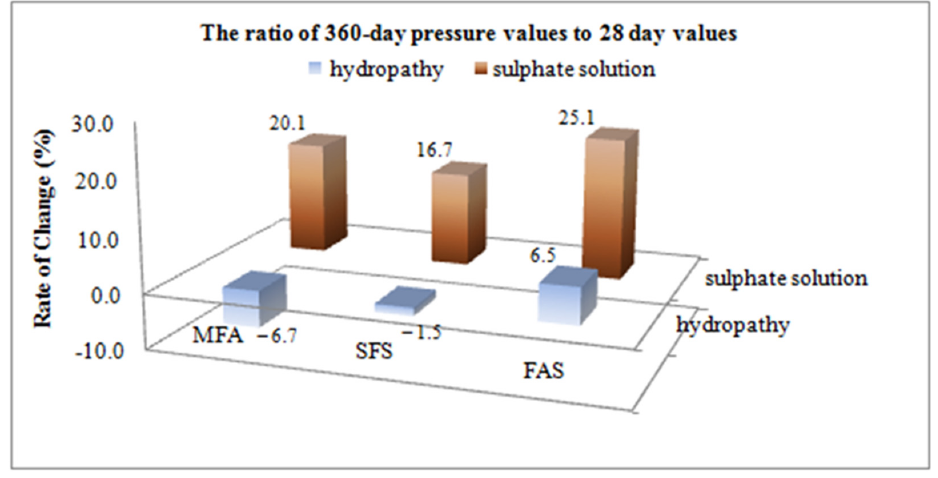
Figure 7. Effects of mineral admixtures on strength variation for ratio of 360 to 28 days values.